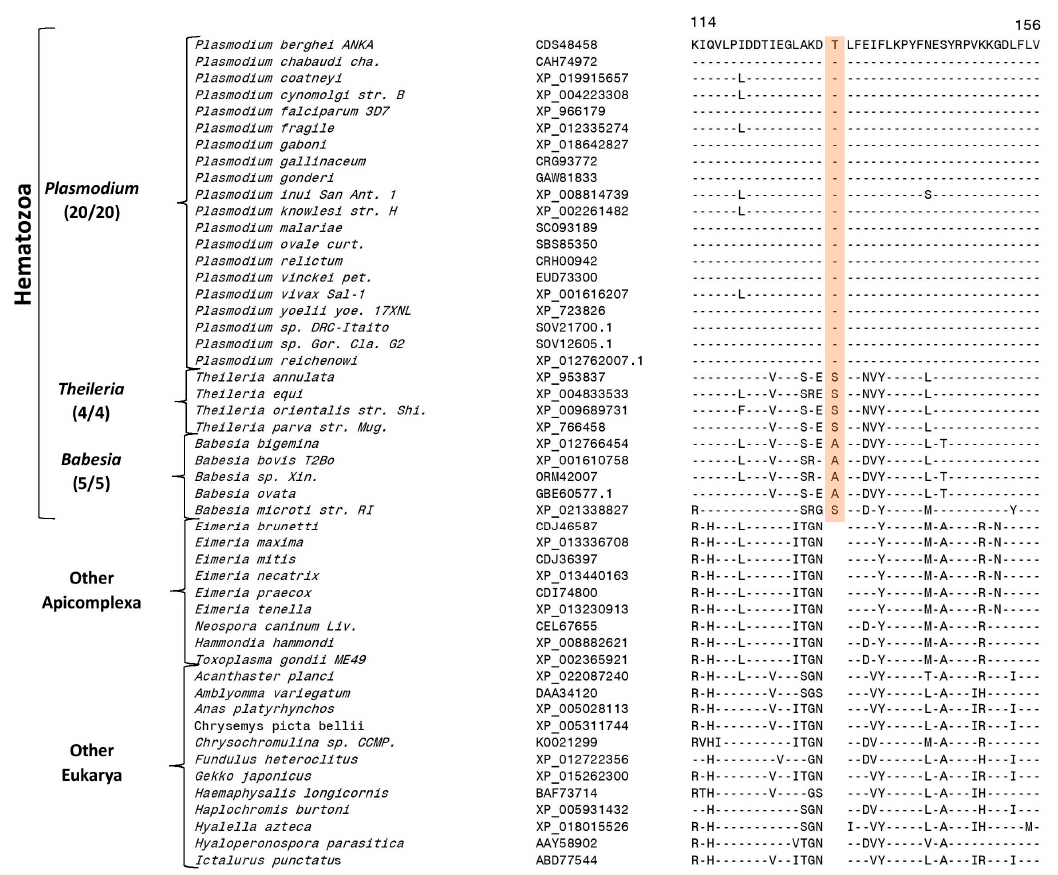
Figure 2. Partial sequence alignment of the cell division cycle protein Cdc48 showing a 1-aa insertion in a conserved region (boxed) which is exclusively found in all available homologs from members of the class Hematozoa. The dashes (-) in the alignment indicate identity with the amino acid residues shown in the top sequence. Accession numbers for each sequence are indicated in the second column. Information for five additional CSIs that are also specific for the class Hematozoa are shown